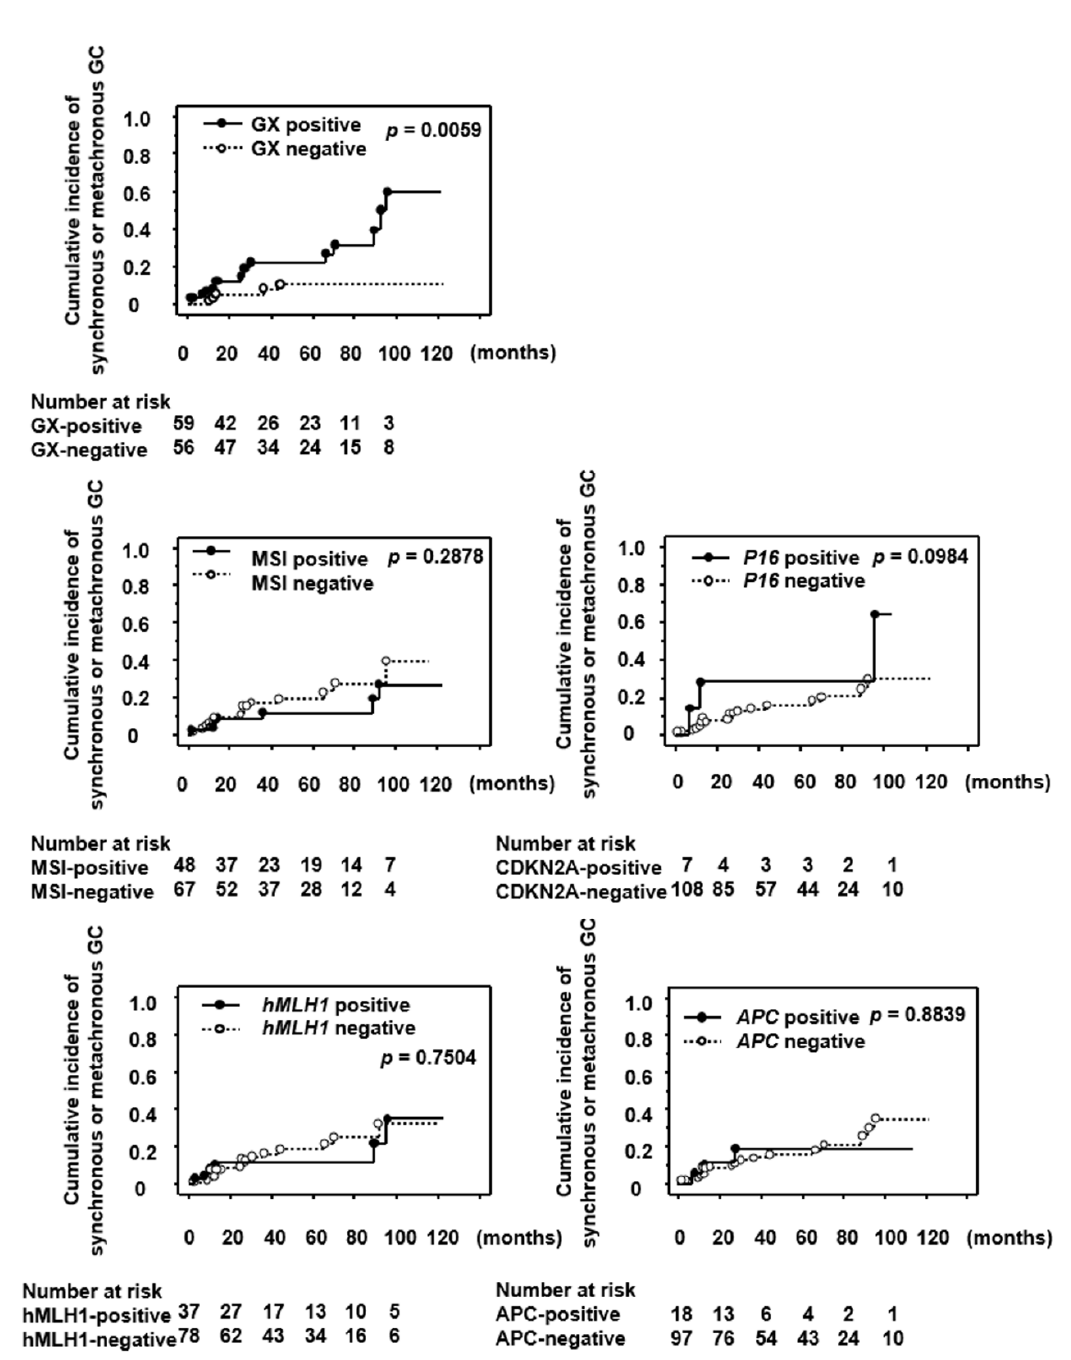
Figure 1. Cumulative incidence of synchronous/metachronous gastric cancer during endoscopic follow-up (median, 55 months; range, 12–122 months) in patients after ESD treatment. GX, gastric xanthelasma; MSI, microsatellite instability; hMLH1 , human mutL homolog 1 ; CDKN2A , cyclin-dependent kinase inhibitor 2A ; APC , adenomatous polyposis coli .